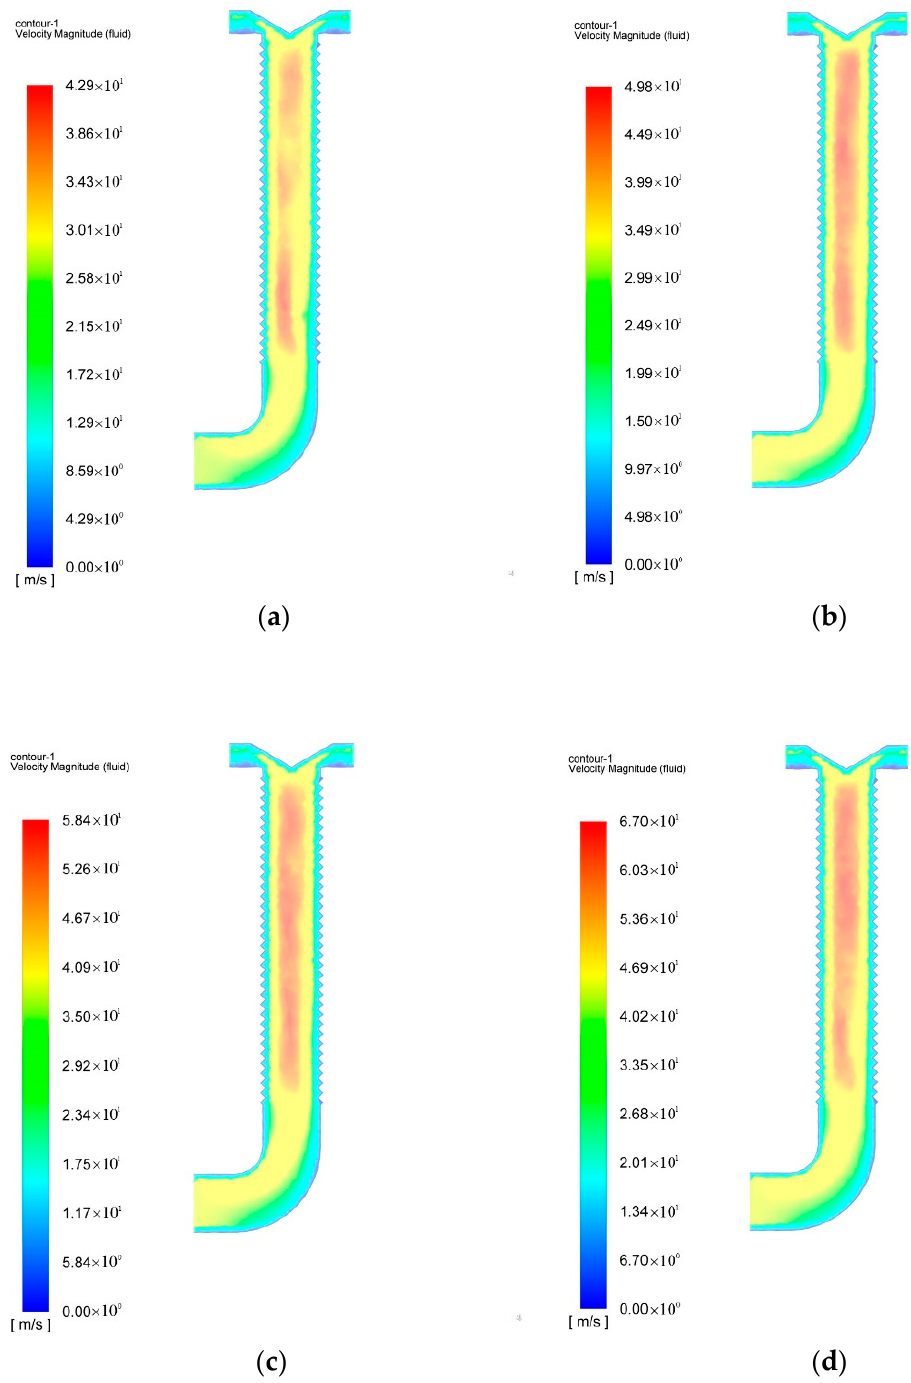
Figure 9. Cloud diagrams of flow fields corresponding to different inlet airflow speeds. ( a ) Inlet air velocity is 25 m/s; ( b ) Inlet air velocity = 30 m/s; ( c ) Inlet air velocity = 35 m/s; ( d ) Inlet air velocity = 40 m/s.